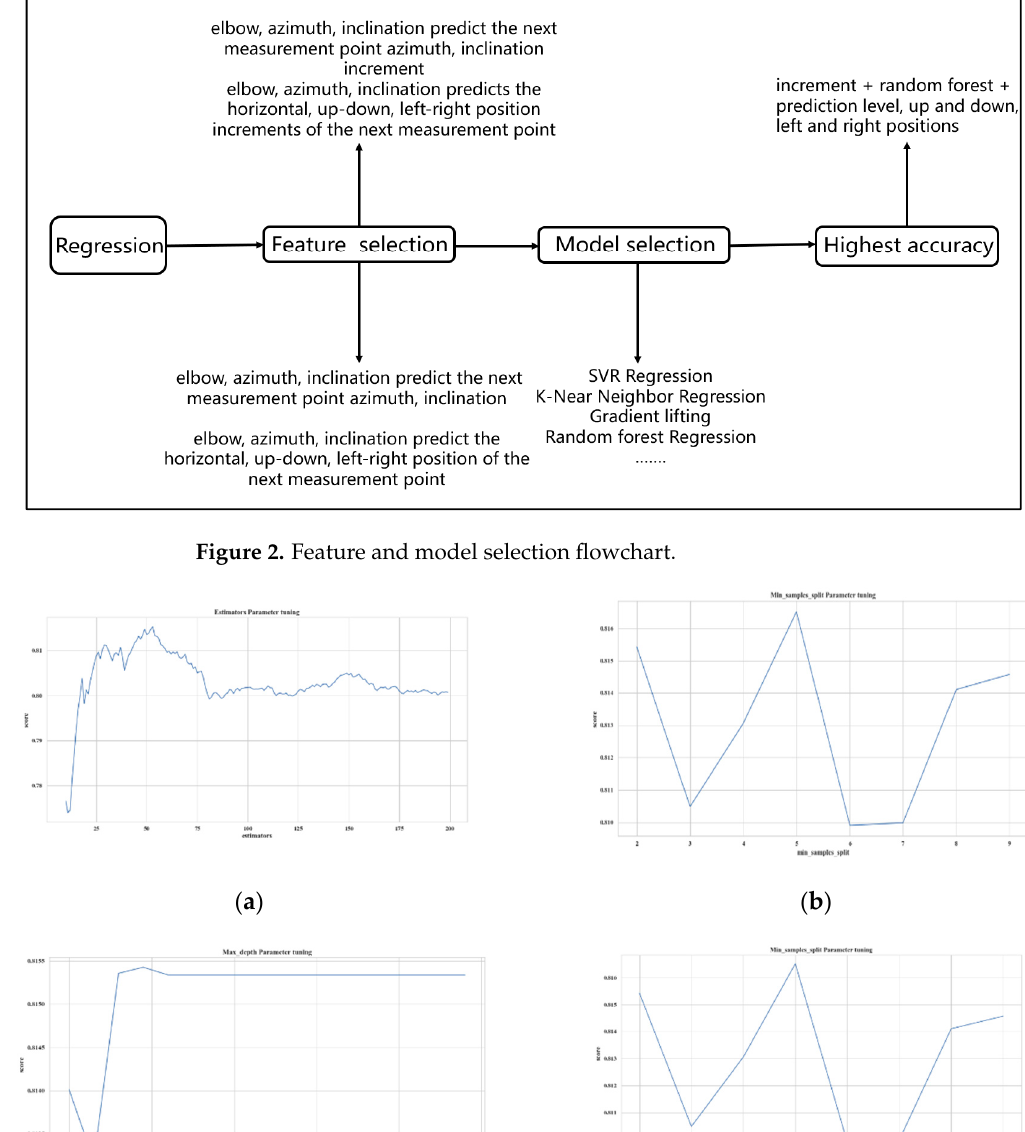
Figure 2. Feature and model selection flowchart.